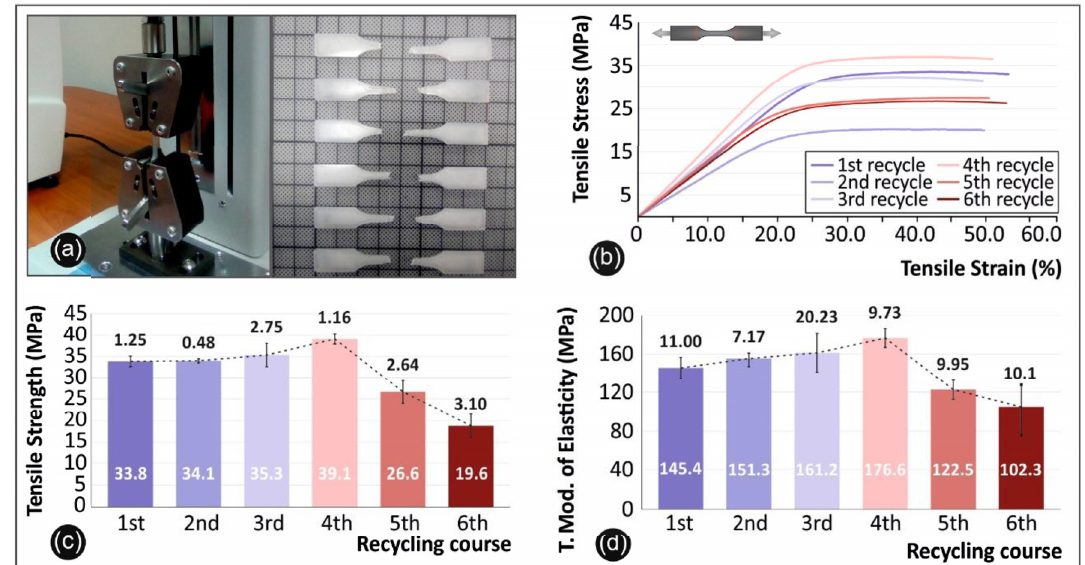
Figure 4. Tensile tests: ( a ) device experimental setup and specimens after the test, ( b ) stress strain graphs from the no 2 specimen of each recycle course, ( c ) comparison of the tensile strength average values along with the calculated deviation from each recycle course studied, and ( d ) comparison of the tensile modulus of elasticity average values along with the calculated deviation from each recycle course